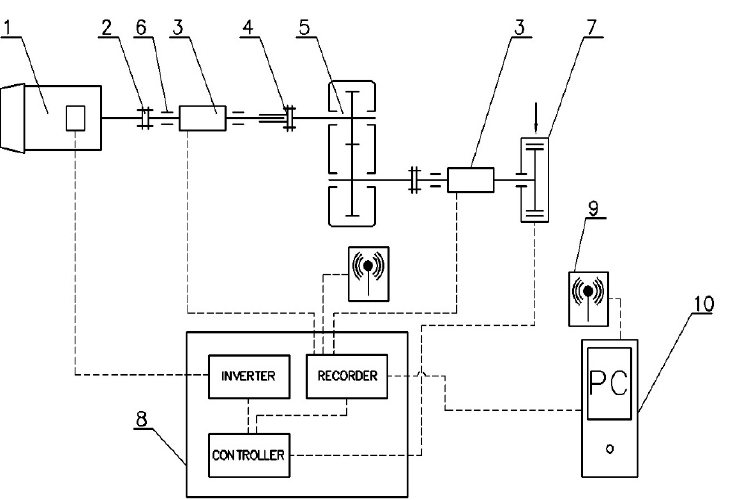
Figure 4. An outline of the rig for carrying out fatigue tests on cylindrical gears. Key: 1—motor, 2—clutch, 3—torque meter, 4—disengaging clutch, 5—analysed gear train, 6—bearing support, 7—powder brake, 8—control box, 9—WiFi connectivity, 10—computer.